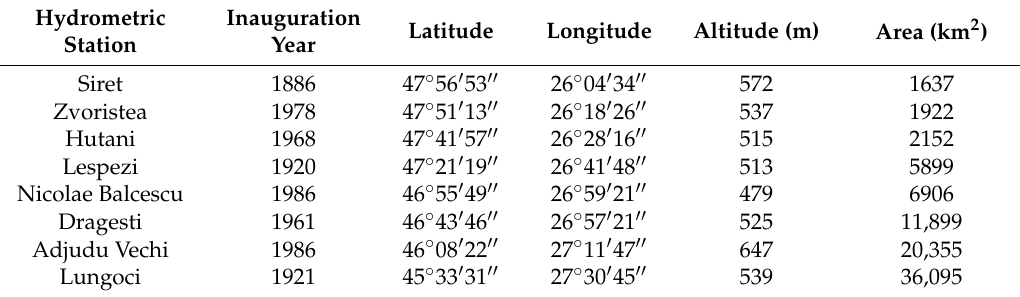
Table 1. Characteristics of hydrometric stations on the Siret